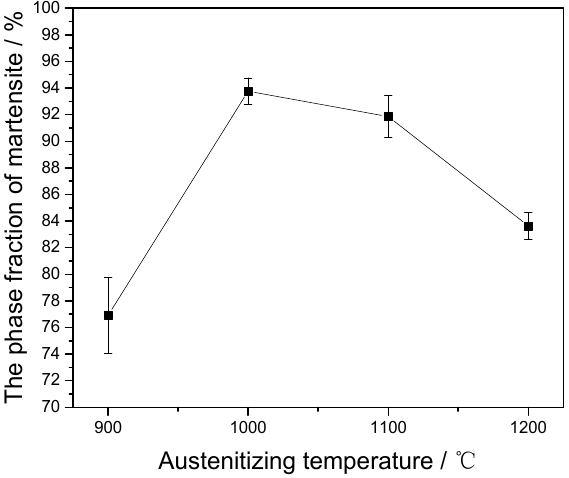
Figure 8. The area fraction of martensite of the samples upon different austenitizing temperatures.